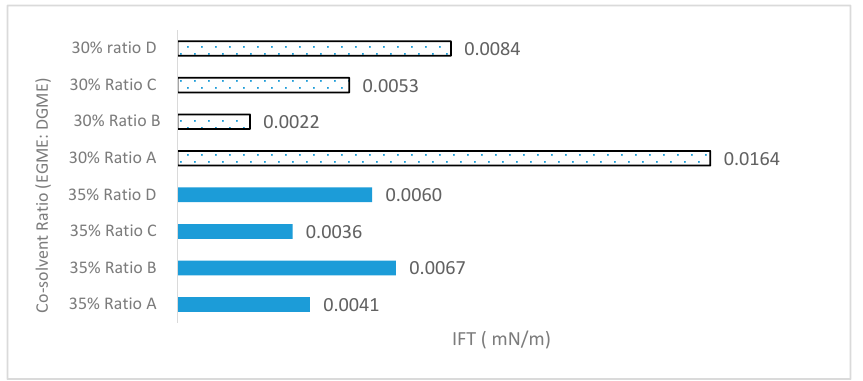
Figure 6. IFT at 60 min with as-synthesized surfactant in the presence of EGME/DGME at different ratios.